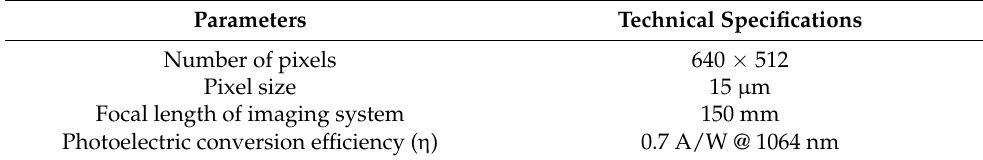
Table 2. Main technical parameters of the SH640